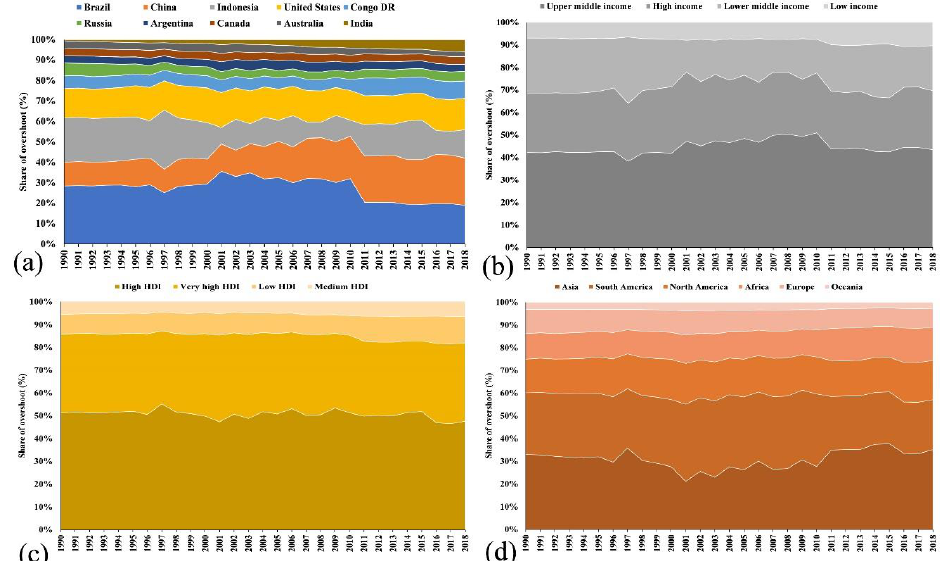
Figure 3. Annual share of overshoot (%) of excess GHG emissions from the global food system (1990–2018). The annual shares of ( a ) 10 countries, ( b ) four income groups (as per World Bank), ( c ) four HDI categories (as per HDR, 2020), and ( d ) six continents.